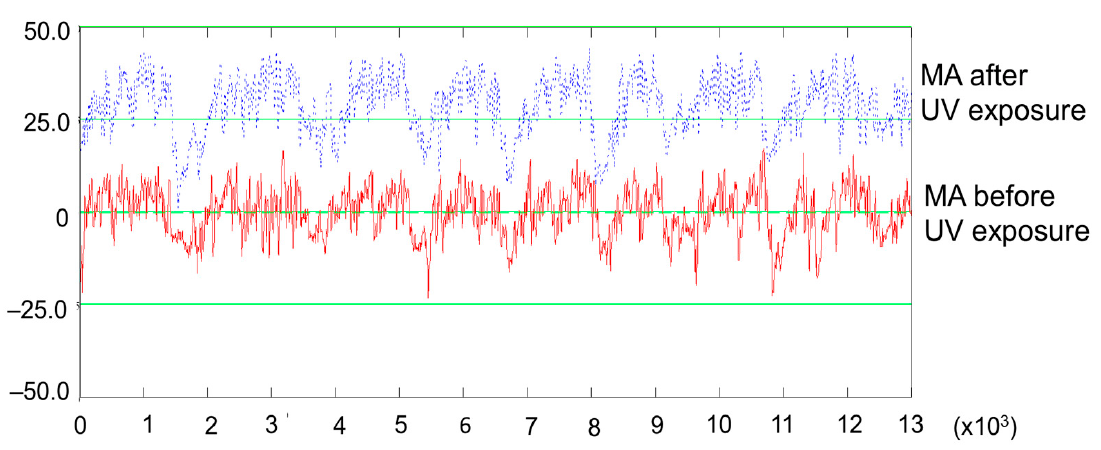
Figure 10. Details of the roughness profiles measured on the MA samples (shown offset and covering a length of 13 mm). Red—before treatment; blue—after UV treatment.